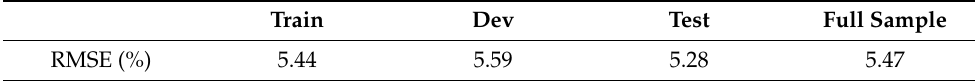
Table 4. Mean values of the RMSE in the different divisions of the sample.